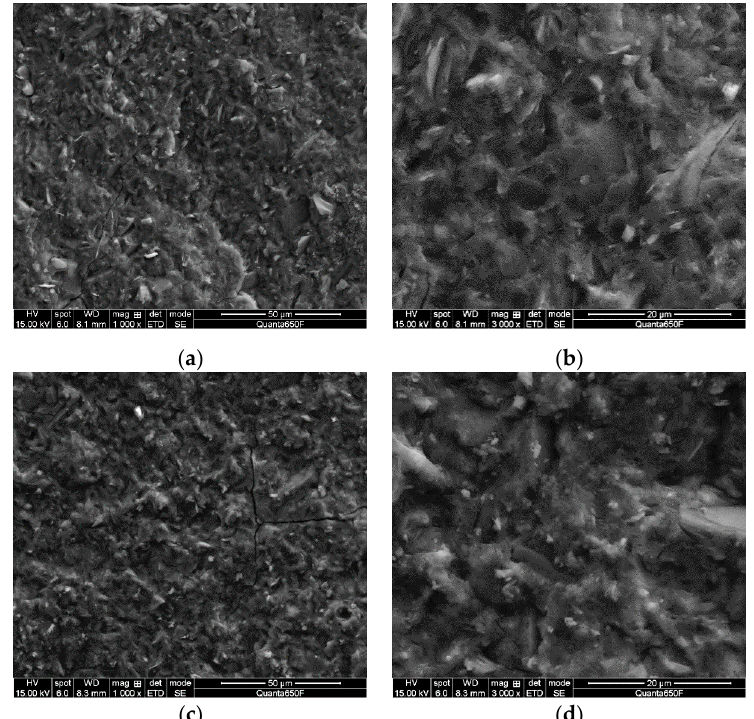
Figure 4. SEM micrographs of fresh fracture surfaces of the Na-geopolymers having a strength of 68 MPa ( a , b ) and MIBC-containing Na-geopolymers having a strength of 83 MPa ( c , d ). Both specimens exhibit a microstructure comprising dense particulates. No meaningful difference between the microstructures of the fresh fracture surfaces was observed. Cracks could be created during sample preparation or while observing the samples under the high vacuum of